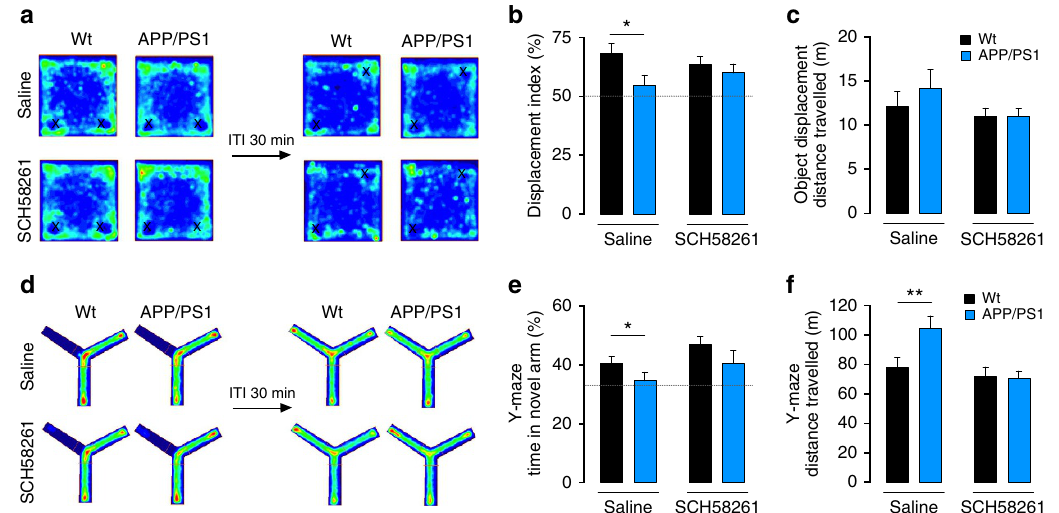
Figure 6 | Treatment with A 2A R blockers restores one-trial memory impairment in APP/PS1 mice. ( a ) Average occupation plot representing the pattern of exploration of the mice in the object displacement test. Mice were treated with SCH58261 or saline for 6 days ( b ) Bar graph representing the percentage of time spent by mice exploring the displaced object. The displacement index is higher in wt saline ( n ¼ 12) when compared with APP/PS1 saline ( n ¼ 9, * P ¼ 0.034, two-way ANOVA, genotype effect; Sidak’s multiple comparisons test wt saline versus APP/PS1 saline , * P ¼ 0.0374). By contrast, whereas SCH58261 is devoid of effects in wt ( n ¼ 11, Sidak’s multiple comparisons test wt saline Saline versus wt SCH58361 , P ¼ 0.594), it reverted the lower percentage of time that APP/PS1 mice interacted with the novel object ( n ¼ 10, Sidak’s multiple comparisons test APP/PS1 saline versus APP/PS1 SCH58361 , P ¼ 0.6047). ( c ) No alterations were found in the average distance travelled by mice (wt Saline : 12.2 ± 1.6m, n ¼ 12, APP/PS1 Saline : 14.5 ± 1.9m, n ¼ 9, P ¼ 0.405; wt SCH58261 : 11.0 ± 0.9m, n ¼ 11, APP/PS1 SCH58261 : 11.0 ± 0.9m, n ¼ 10, P ¼ 0.096, two-way ANOVA). ( d ) Average occupation plot of exploration in the Y-maze task. ( e ) Bar graph representing the percentage of time spent in the novel arm by wt and APP/PS1 mice treated with SCH58261 or saline for 7 days. When comparing APP/PS1 ( n ¼ 9) and wt ( n ¼ 12) mice in the saline groups, we observed a difference in the percentage of time spent in the novel arm (* P ¼ 0.024, two-way ANOVA, genotype effect; Sidak’s multiple comparisons test wt saline versus wt SCH58361 , * P ¼ 0.0347). SCH58261 treatment had no effect in wt groups ( n ¼ 11, Sidak’s multiple comparisons test wt saline versus wt SCH58361 , P ¼ 0.901), but reverted the memory deficit in APP/PS1 mice ( n ¼ 10, Sidak’s multiple comparisons test APP/PS1 saline versus APP/PS1 SCH58361 , P ¼ 0.410) ( f ) Distance travelled in the test phase of the modified Y-maze (wt Saline : 77.9 ± 6.7m, n ¼ 12, APP/PS1 Saline : 104.2 ± 8.6m, n ¼ 9; wt SCH58261 : 71.5 ± 6.7m, n ¼ 11, APP/PS1 SCH58261 : 70.8 ± 4.8m, n ¼ 10, ** P ¼ 0.006, two- way ANOVA with Sidak’s multiple comparisons test). Horizontal dashed lines in b and e represent the random displacement values for better